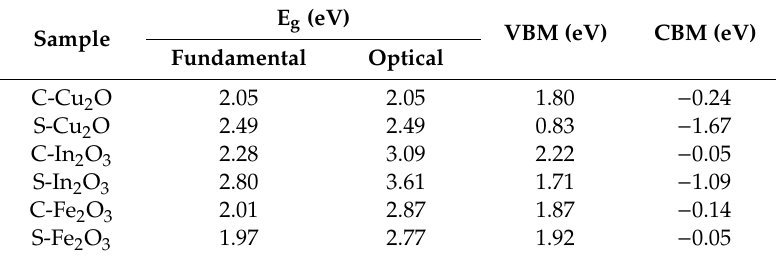
Table 5. Resume of energy gaps and band edges levels in semiconductor metal